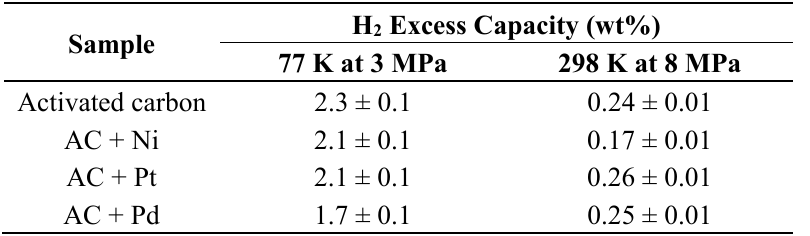
Table 2. Hydrogen uptake for pristine activated carbon and Ni-, Pt- and Pd-anchored activated carbon at 77 and 298